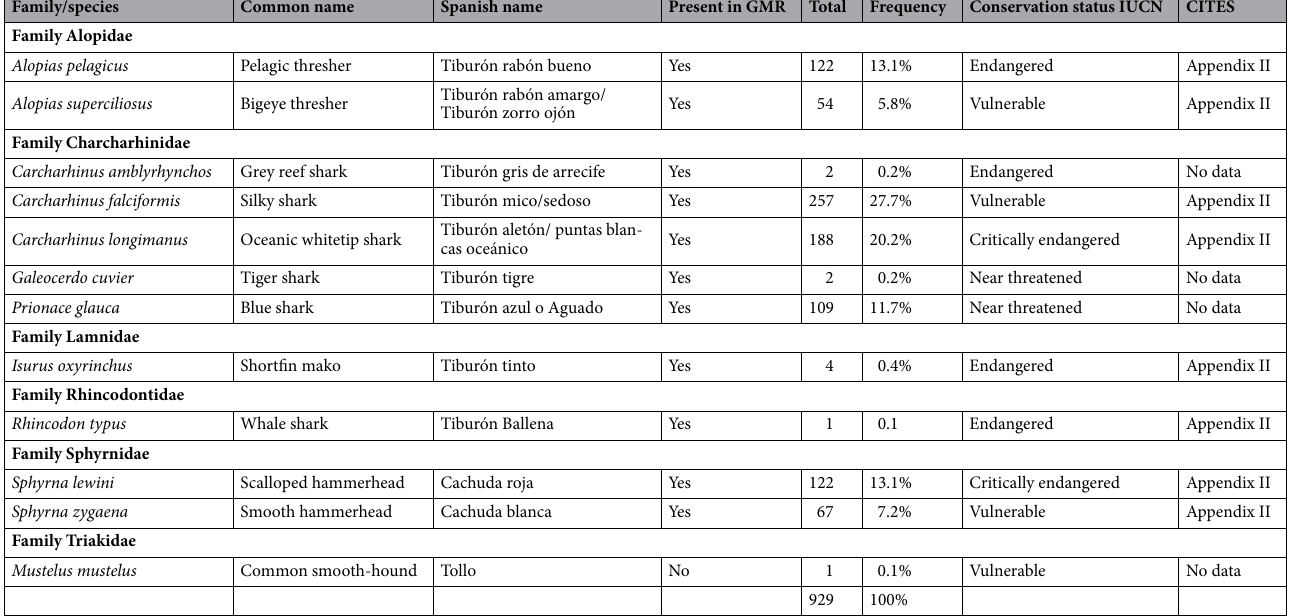
Table 1. Conservation status of species of sharks from vessel Fu Yuan Yu Leng 999 intercepted within the limits of the Galápagos Marine Reserve. Data from www. iucn. org and www. cites. org, updated to December 2020. All species except Mustelus mustelus have been reported for the Galápagos Marine Reserve (GMR) (Supplementary Information Table